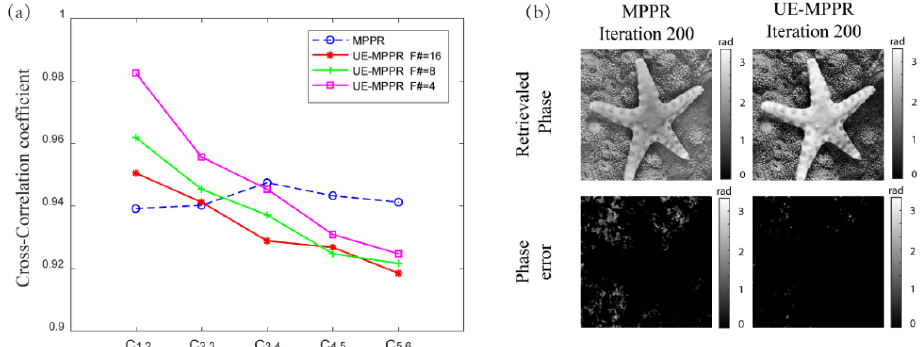
Figure 3. Comparison of mean square error (MSE) plots in phase results for various methods as the noise level increases. ( a ) The result by adding white noise. ( b ) The result by adding speckle noise.